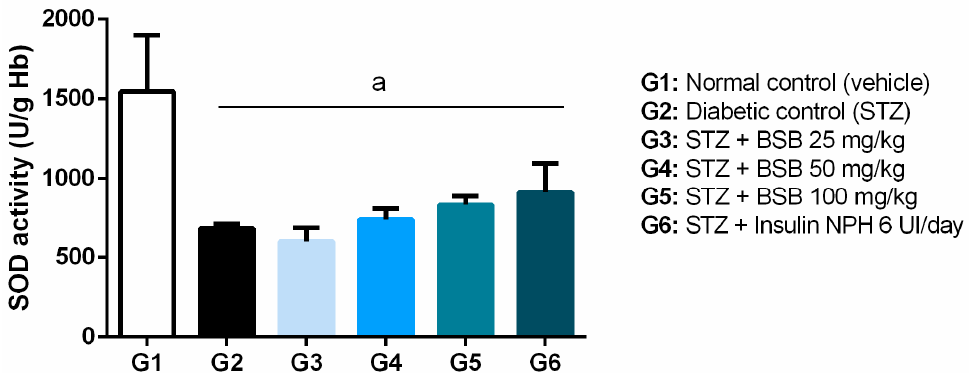
Figure 5. Antioxidant activity of superoxide dismutase (SOD) in erythrocytes of STZ-induced diabetic rats at the end of 4 weeks of treatment with bacuri seed butter (BSB). a p < 0.05 vs. normal control; one-way ANOVA and Tukey’s post hoc test.